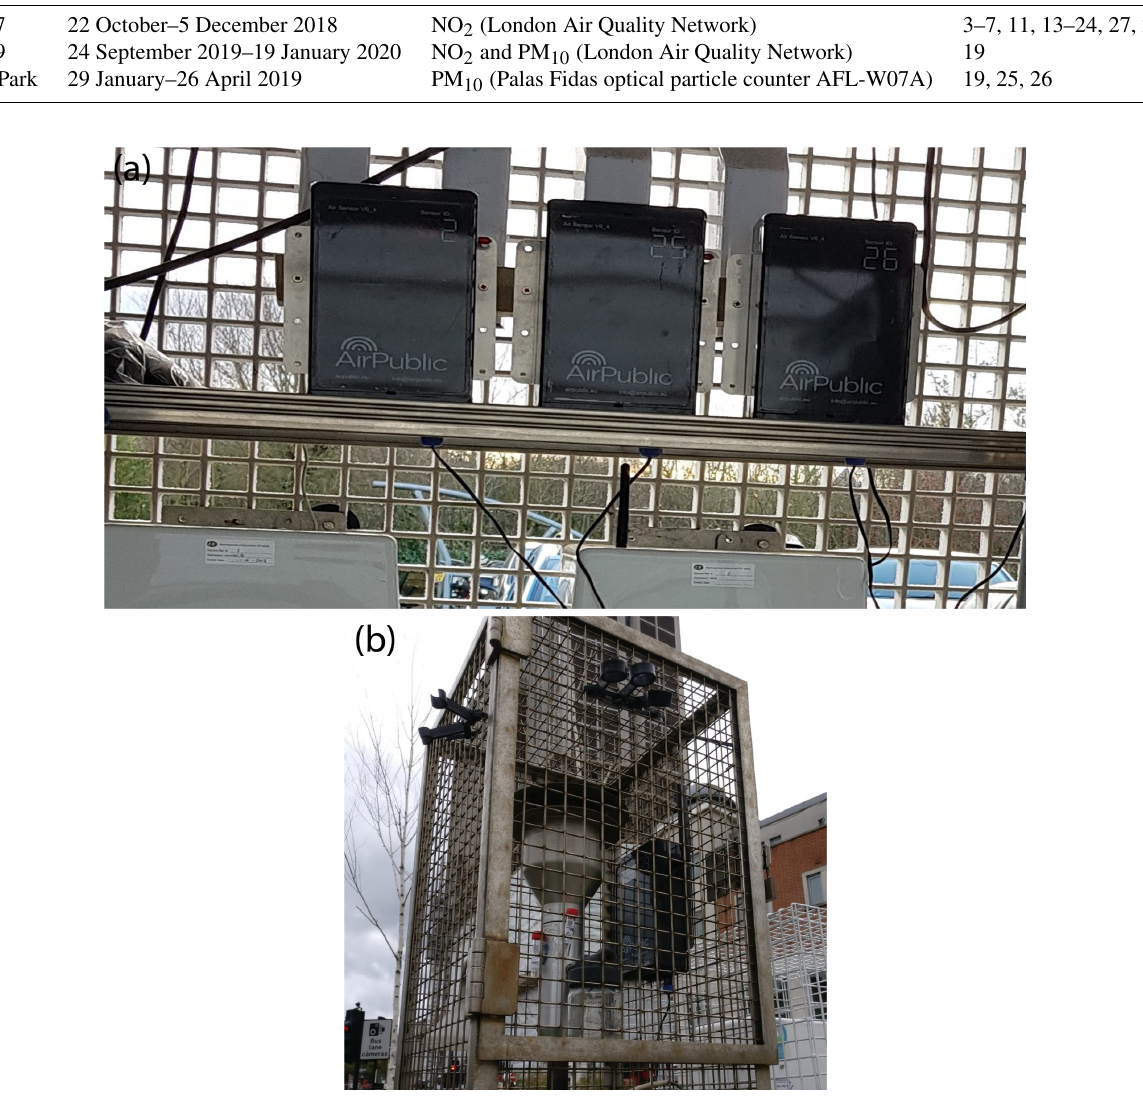
Figure 2. Examples of the co-location set-up of the AirPublic low-cost sensor nodes with reference measurement stations at sites (a) CarPark and (b)